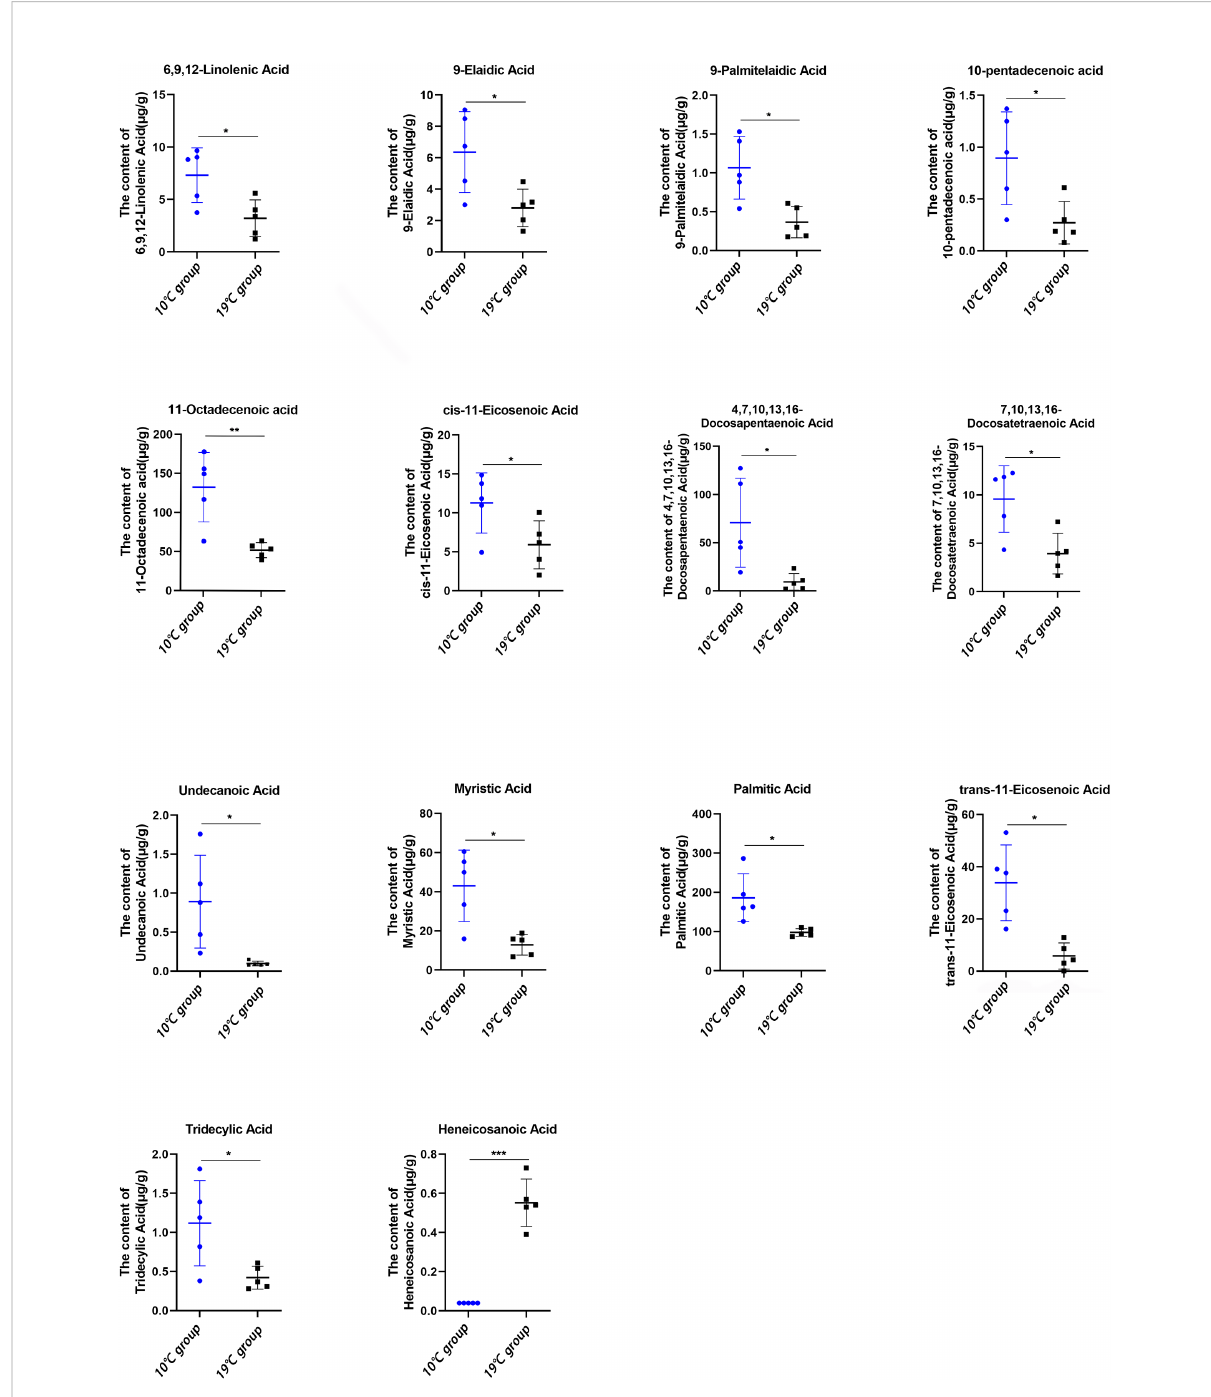
FIGURE 5 Absolute concentration of free fatty acids in the liver between the 10°C and 19°C groups. *p < 0.05, **p < 0.01, ***p <